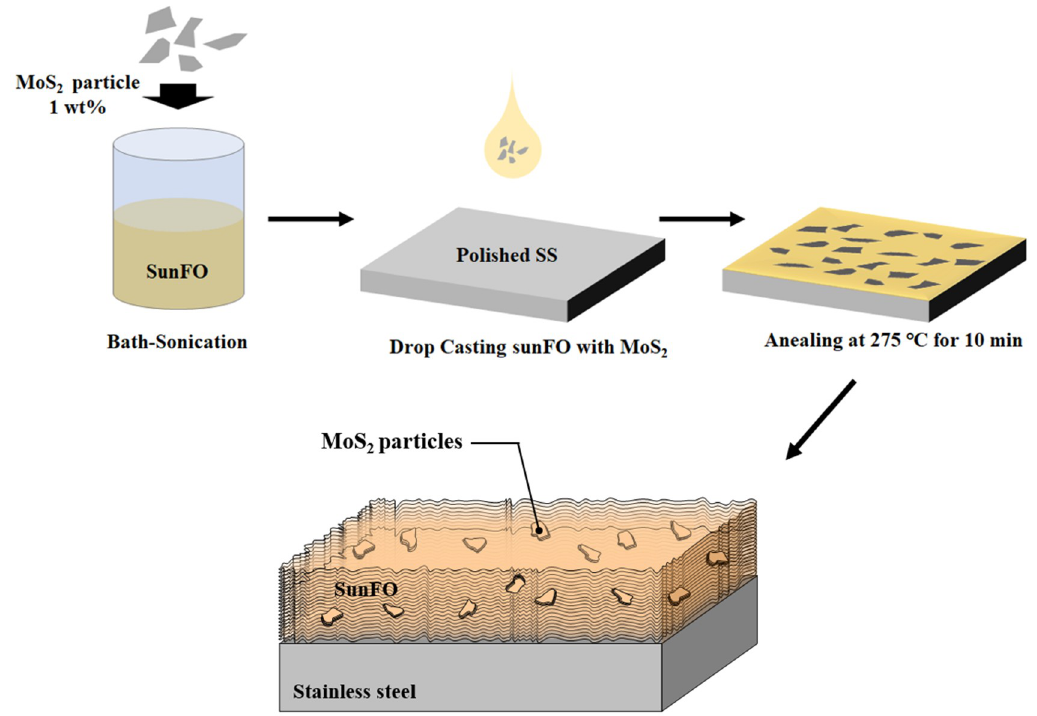
Figure 1. Schematic diagram of the experimental procedures and expected coating structure.